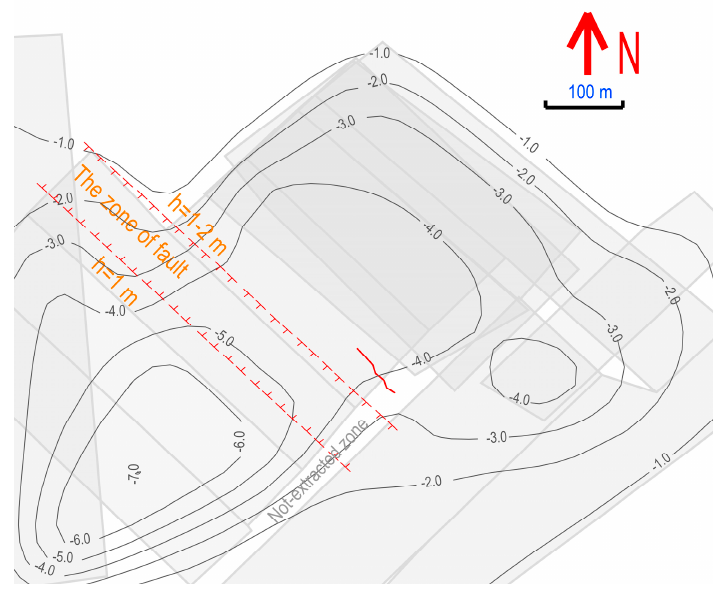
Figure 11. The distribution of the calculated land surface subsidence resulting from the past extraction (values in meters).